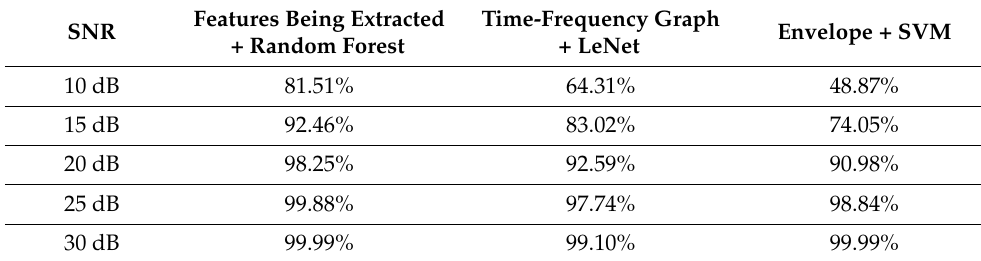
Table 5. Accuracy with various methods of specific emitter